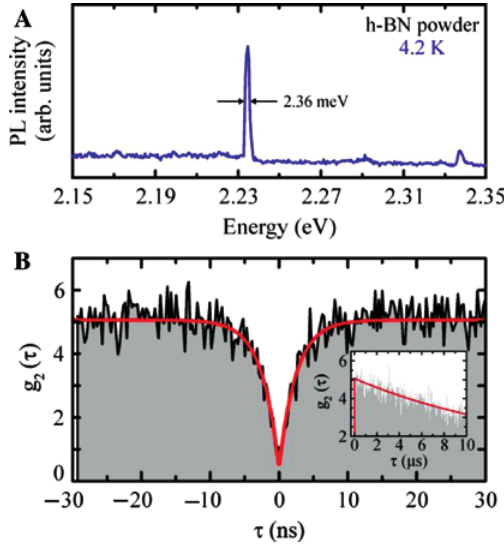
Figure 18: Quantum emitters in hexagonal boron nitride. (A) Low-temperature PL spectrum of a narrow line emitting center in h-BN powder measured at below-band-gap excitation energy. (B) Photon coincidence correlation histogram displaying a second-order autocorrelation function g ( τ ), where τ denotes the time interval 2 between the coincidence counts, obtained for the narrow emission line occurring at slightly above 2.23 eV in the spectrum shown in panel